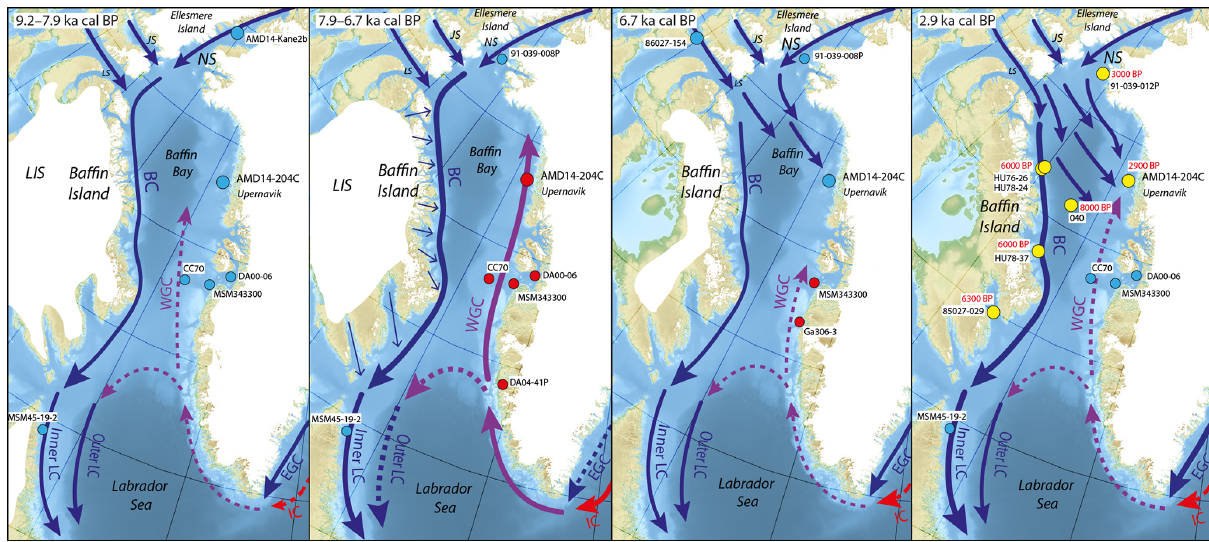
Figure 8. Map showing the oceanographic conditions in the Baffin Bay and Labrador Sea areas from 9.2 to 2.9ka based on this core and other cores from the area: AMD14-Kane2b (Georgiadis et al., 2020), MSM45-19-2 (Lochte et al., 2019), CC70 (Gibb et al., 2015), DA00-06 (Lloyd et al., 2005), DA04-41P (Seidenkrantz et al., 2013), MSM343300 (Perner et al., 2012; Moros et al., 2016), 91-039-008P (Levac et al., 2001), 86027-154 (Pie´nkowski et al., 2014), 91-039-012P (Levac et al., 2001; Knudsen et al., 2008), HU76-26, HU78-24, HU-78-37 (Osterman and Nelson, 1989), 040 (Aksu, 1983), and 85027-029 (Jennings, 1993). Red and blue cores represent relatively warmer and colder conditions, respectively. Solid and dashed arrows indicate stronger and weaker ocean currents, respectively. The straight blue arrows at Baffin Island at 7.9–6.7ka indicate meltwater run-off into the ocean. The yellow cores at 2.9ka indicate sediment cores where a change towards an agglutinate-dominated benthic fauna occurred. Red numbers indicate the timing of this transition. Reconstruction of ice-sheet extents are modified from Dyke (2004). Abbreviations: LIS: Laurentide Ice Sheet; LS: Lancaster Sound; JS: Jones Sound; NS: Nares Strait; BC: Baffin Current; LC: Labrador Current; IC: Irminger Current; EGC: East Greenland Current; WGC: West Greenland Current. The ocean bathymetry and bed topography data are derived from GEBCO (Weatherall et al.,